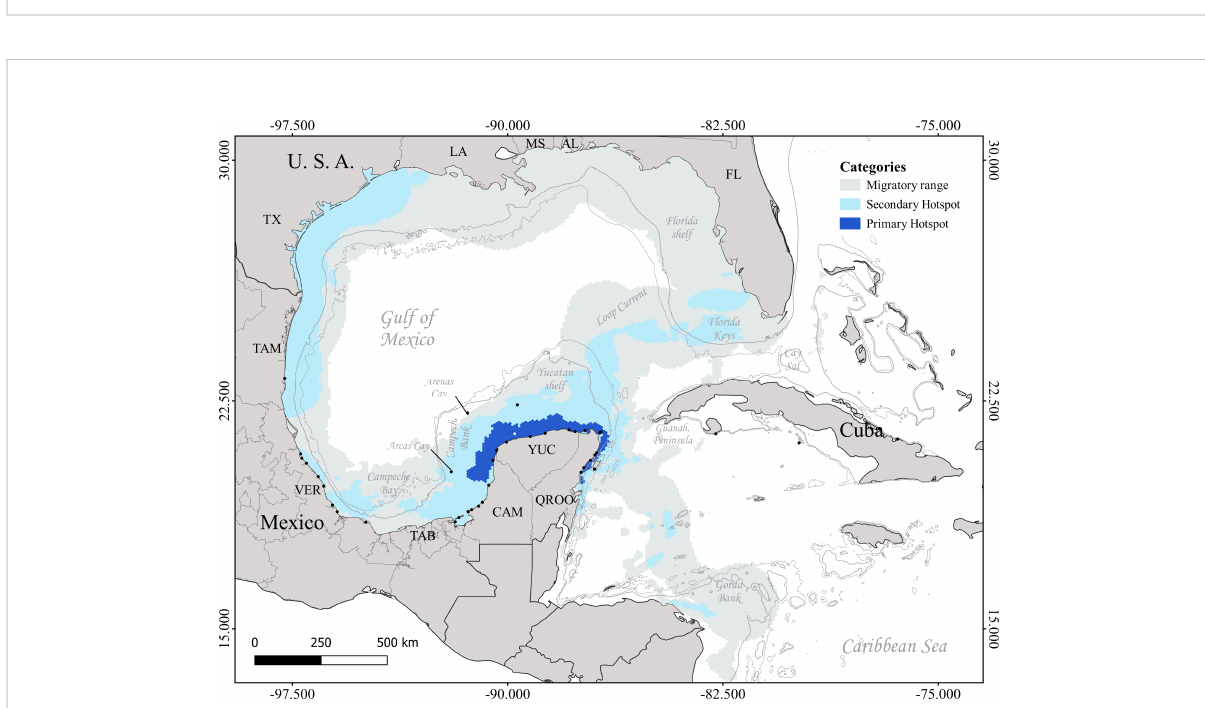
FIGURE 2 Migratory corridor hotspots used by the breeding females of the four marine turtle species satellite tracked from Mexico and Cuba. Continuous thin gray line depicts the 200 m isobath, and the dashed thin line represents the 500 m isobath (https://www.gebco.net/). Black dots represent the releasing sites of the satellite-tracked individuals.